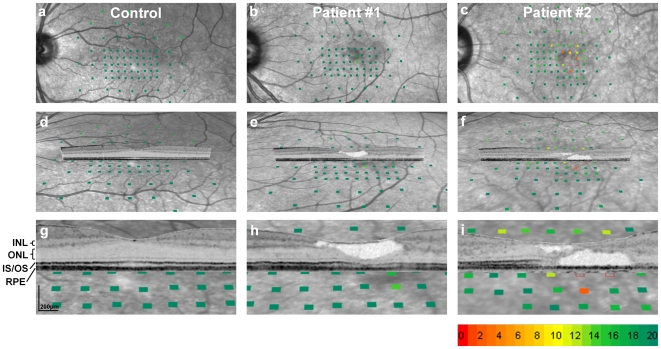
Correlation of topographic and tomographic retinal imaging with functional mapping.Threshold values of retinal sensitivity derived from microperimetry are presented according to the scale below panel i) in 2 dB steps. Normal sensitivity is indicated by green colour, and decreased sensitivity is indicated by red colour; open rectangles demonstrate absolute defects (as defined in Ref [11]). The first column illustrates findings in a normal subject, the middle and right column in two patients with macular telangiectasia type 2. The first row shows functional maps superimposed on near-infrared confocal scanning laser ophthalmoscopy (cSLO) images of the central retina. The second and third row (d–i) show the functional maps superimposed on the back-tilted cSLO images and a high-resolution spectral-domain optical coherence tomography (SD-OCT) scan. The lower panels (g-i) show enlarged cut-outs of the middle row (d–f). For the normal subject, selected anatomical layers of the retina are indicated for orientation on the left-hand side of panel g (INL: inner nuclear layer; ONL: outer nuclear layer; IS/OS: junction of the inner and outer photoreceptor segment; RPE: retinal pigment epithelium). The tissue defect within the inner retina (e,h) is associated with a normal retinal light sensitivity (green squares), whereas damage to the outer retina (the photoreceptor layers) was accompanied by a strong loss of retinal sensitivity (red filled and red open squares; f,i).